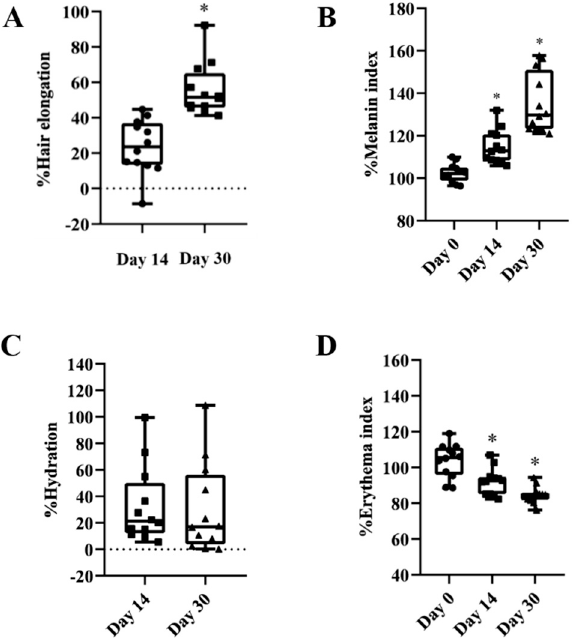
Figure 9. % Hair elongation ( A ), %MI ( B ), % hydration ( C ), and %EI ( D ) of the skin after application of the serum formulation in human volunteers for different periods. Data are reported as mean ± SD ( n = 12). * signifies a significant difference from day 0 ( p < 0.05).